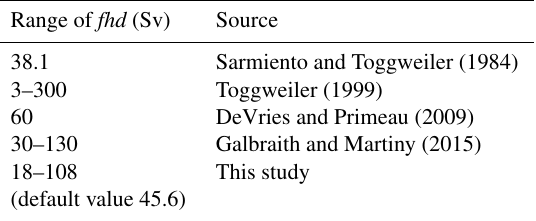
Table 1. High-latitude deep water exchange